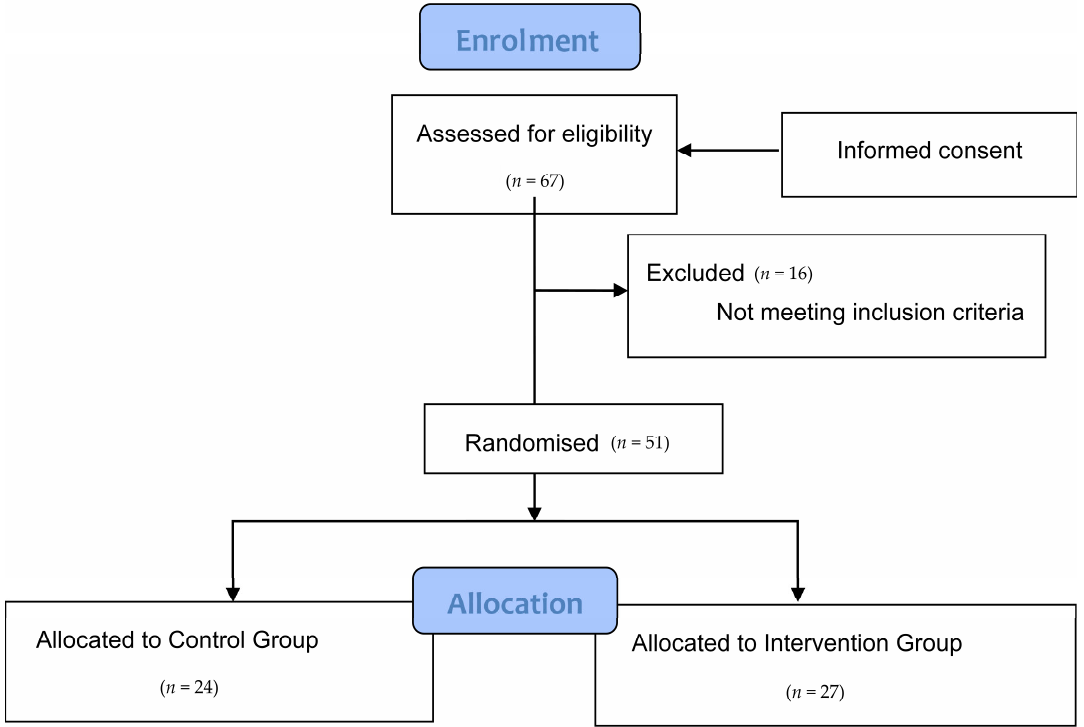
Figure 3. Consort flow diagram.